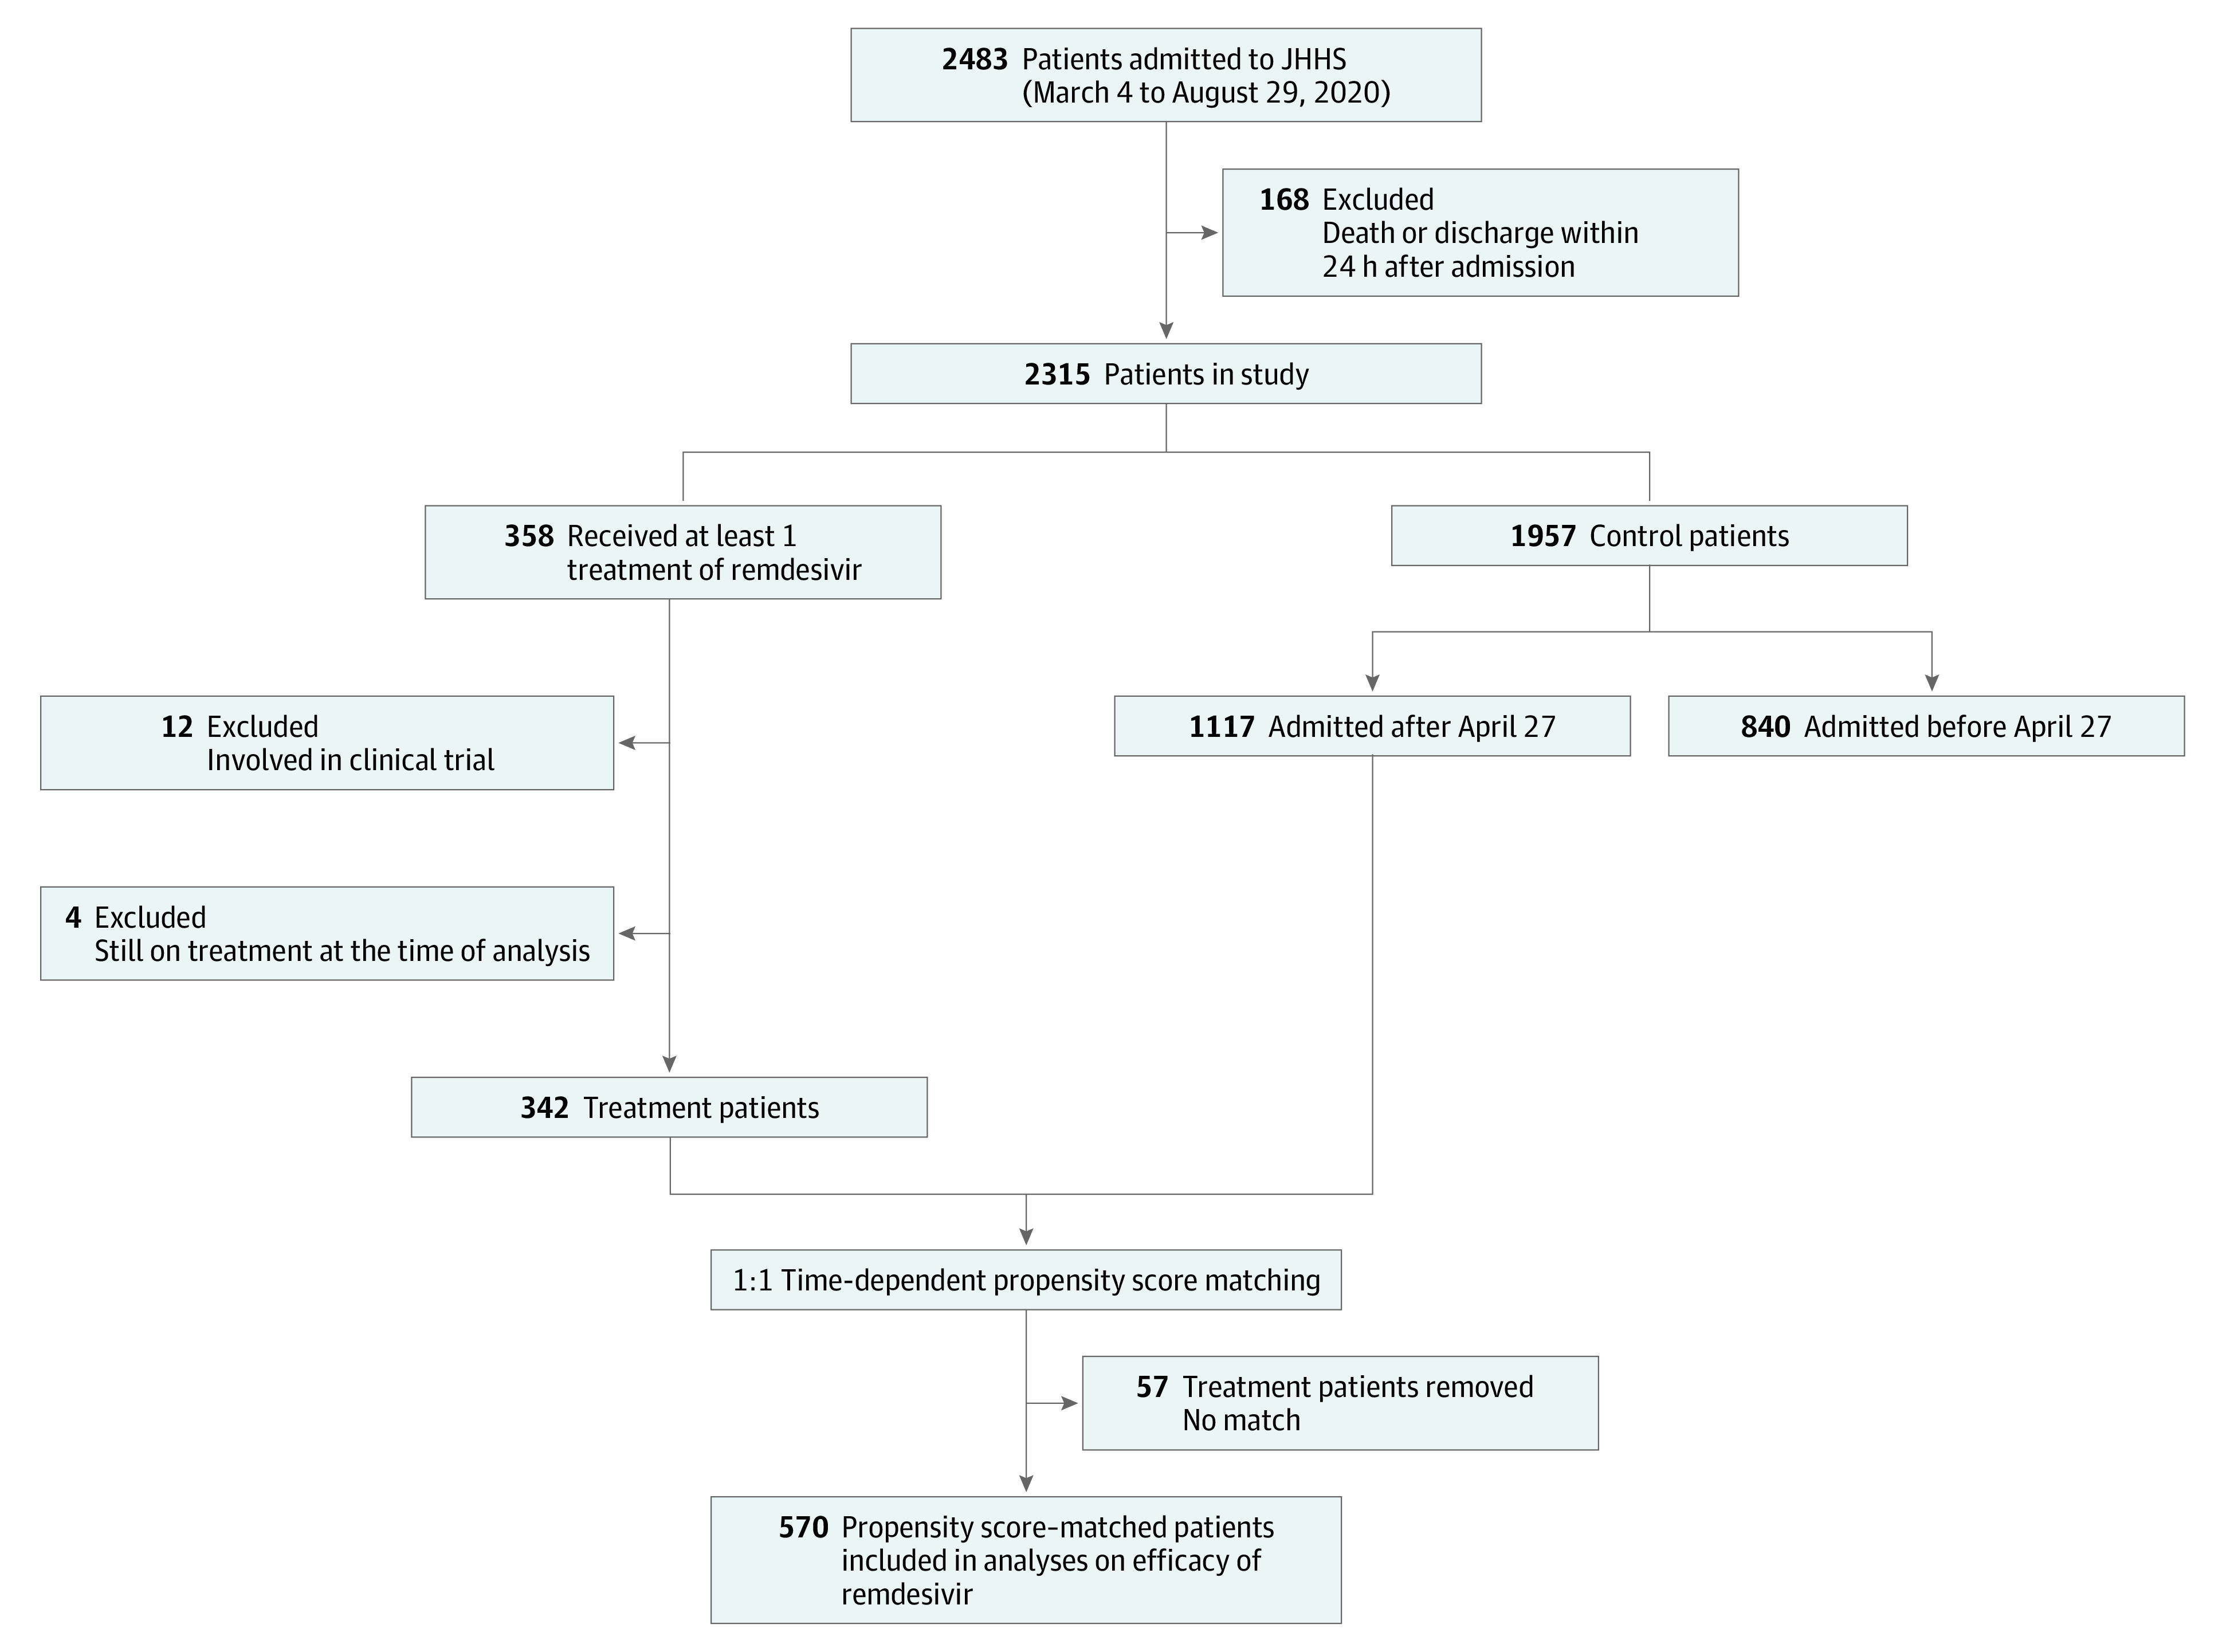
Description of Patients Included in the AnalysisJHHS indicates the Johns Hopkins Health System.